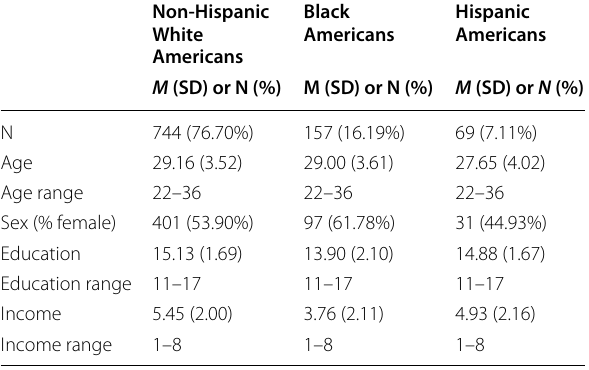
Table 1 Sociodemographic information as a function of ethnoracial